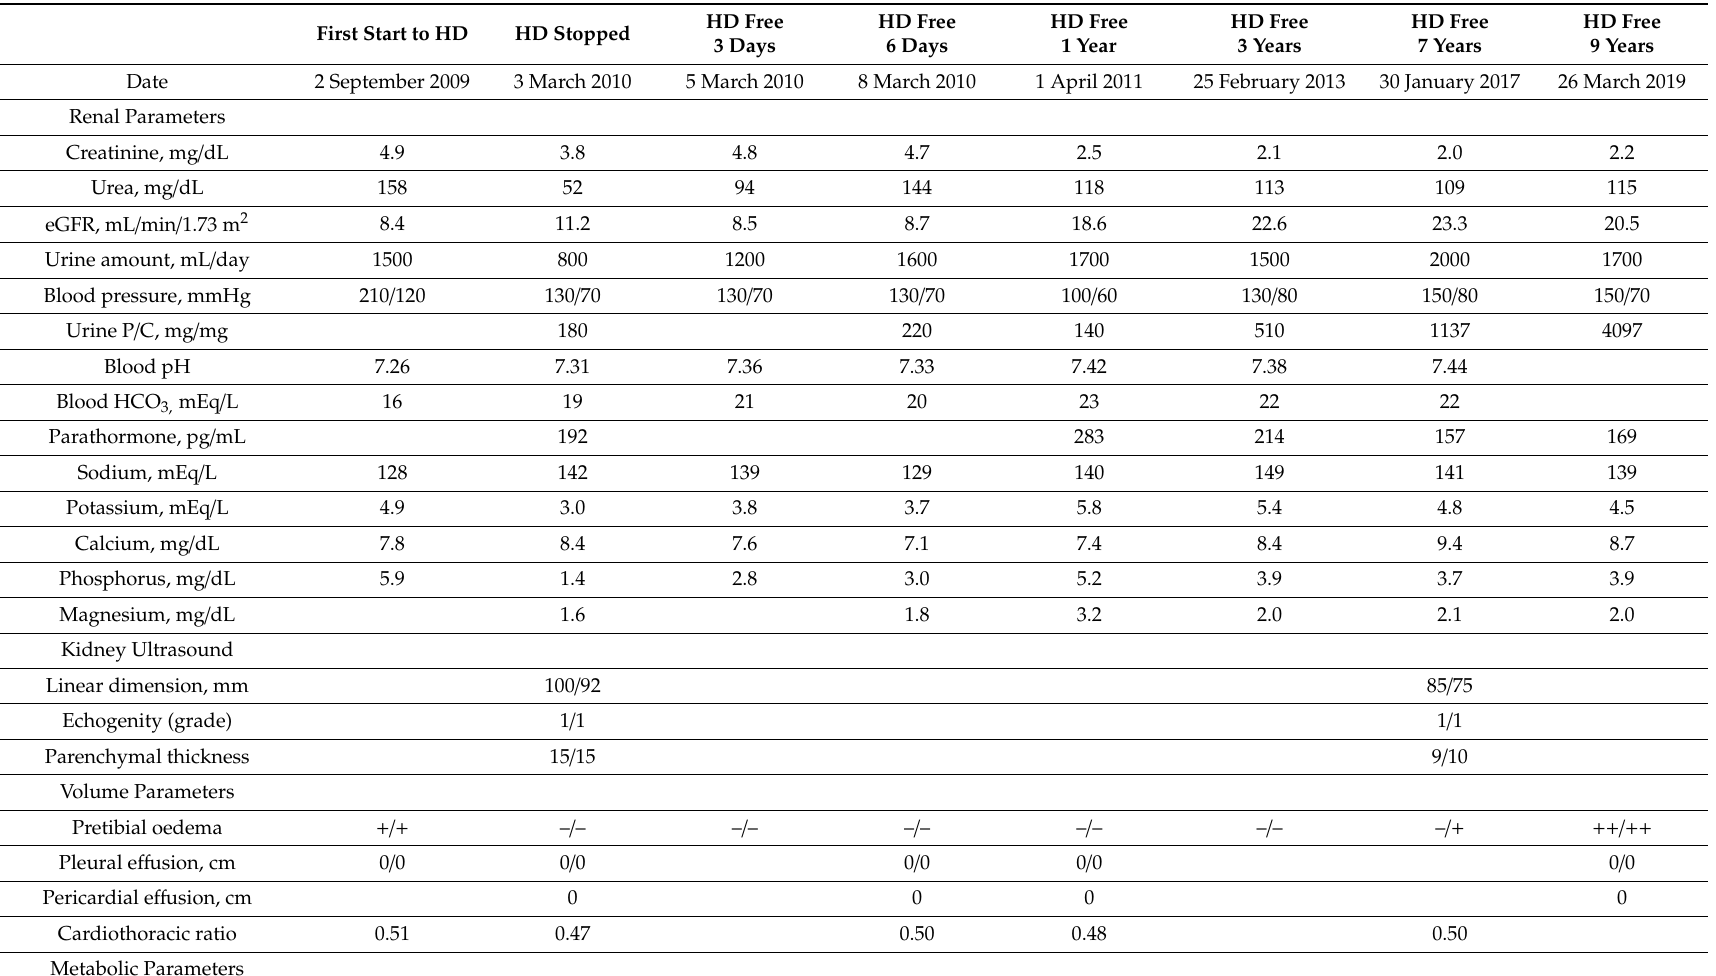
Table 1. Renal, metabolic, nutritional, and fluid load parameters of the